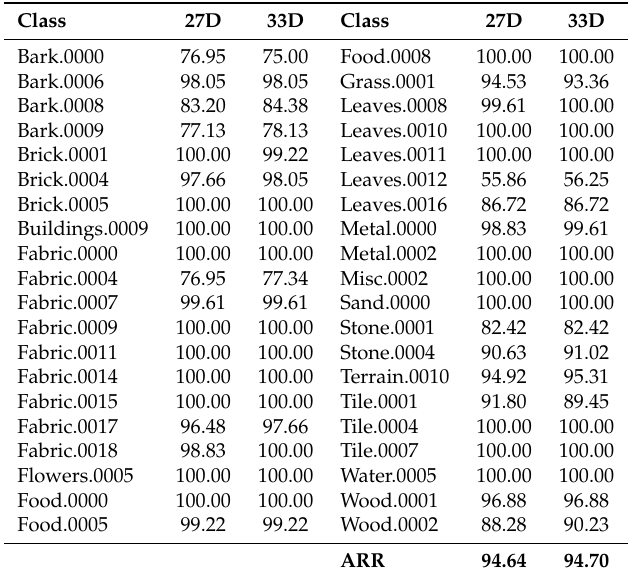
Table 3. Per-class retrieval rate (%) on the Vistex-640 database using the proposed LED+RD method.